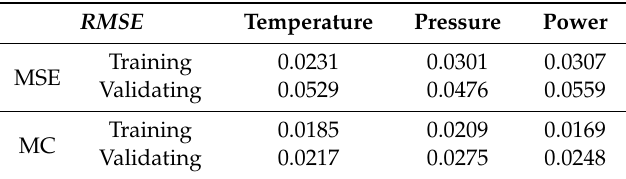
Table 3. The root mean square errors of SAE without the preprocessing